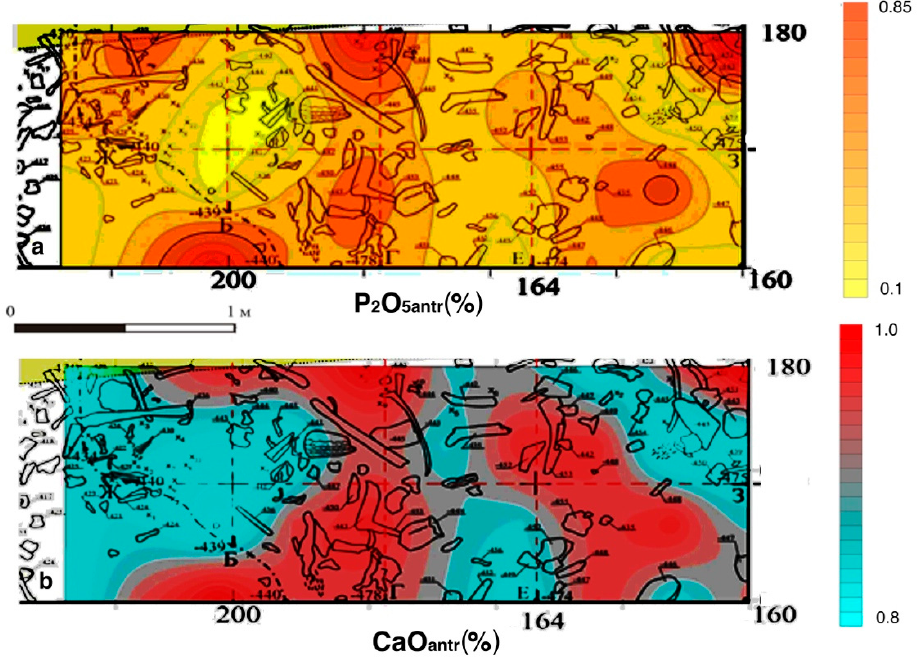
Figure 15. The Yudinovo site. Geochemical maps of ( a ) P 2 O 5anthr and ( b ) CaO antr distributions in the sediments [44], designed by M.Kulkova.